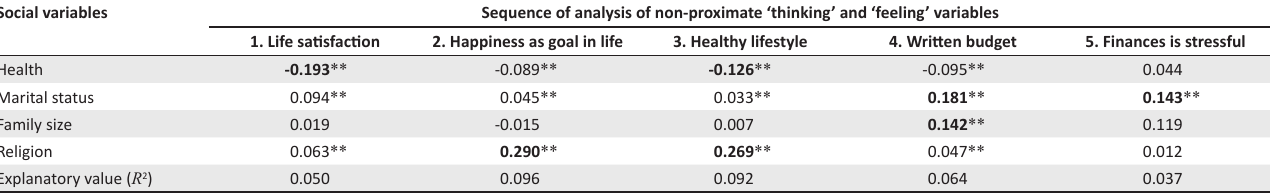
TABLE 6: Results of the sequential analysis illustrating the relationship between the underlying social variables as stochastic determinants of the non-proximate (thinking and feeling) variables. Social variables Sequence of analysis of non-proximate ‘thinking’ and ‘feeling’ variables